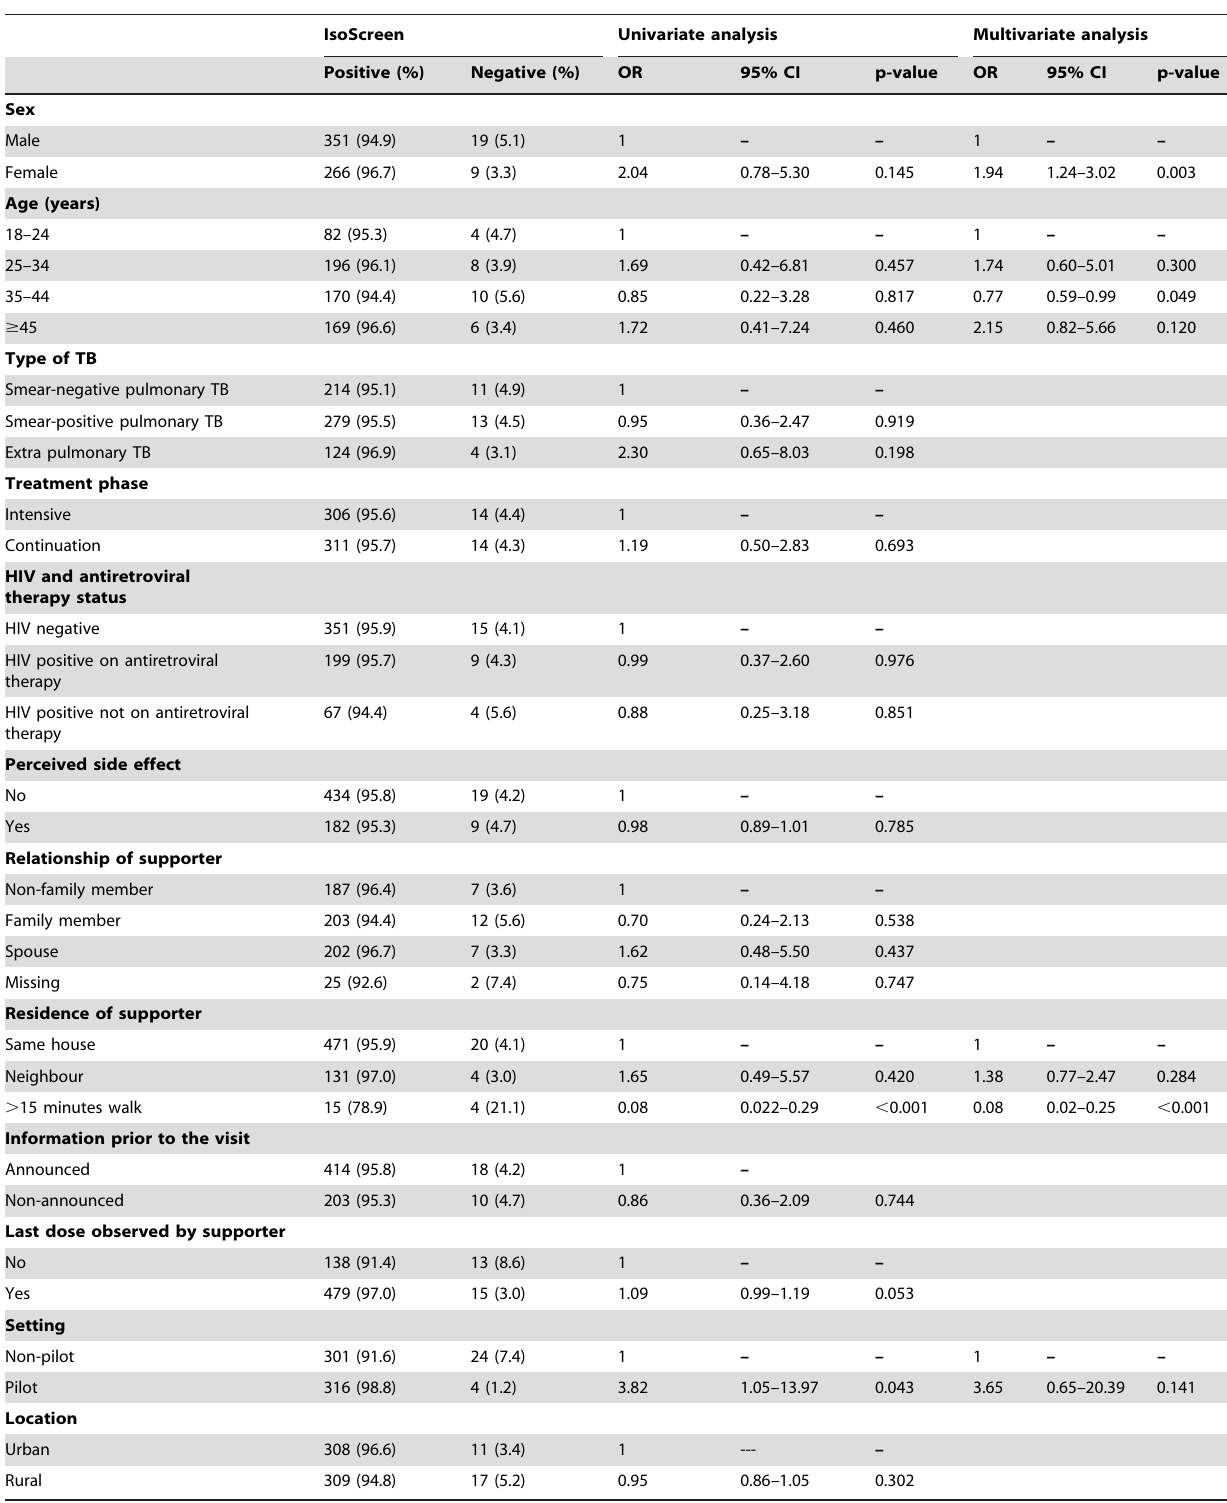
Table 3. Crude and adjusted odds ratios for factors fostering treatment adherence among patients on anti-TB drugs (N